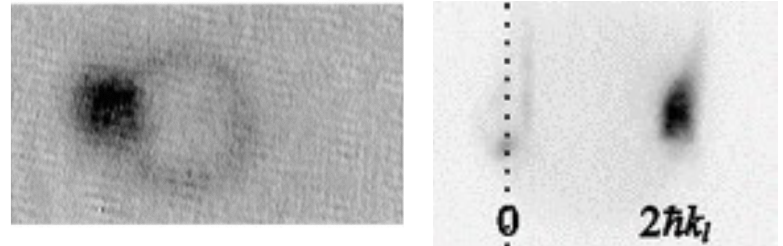
Figure 1. Two examples of momentum halos observed in the experiments with ultracold atoms after exposition to a single far-off detuned laser beam incident from left to right. ( Left ): Absorption image taken after 5.6 ms time-of-flight, showing a ring pattern with radius ¯ hk 0 , resulting from dipole emission of atoms illuminated by a single traveling wave (Adapted with permission from Ref. [5]. Copyright 1999, The American Physical Society). ( Right ): Superradiant Rayleigh scattering experiment, where the absorption image, taken after 45 ms time-of-flight, shows the atoms transferred in the momentum state with p = 2¯ hk 0 surrounded by an halo centered at p = ¯ hk 0 (Adapted with permission from Ref. [6]. Copyright 2008, The American Physical